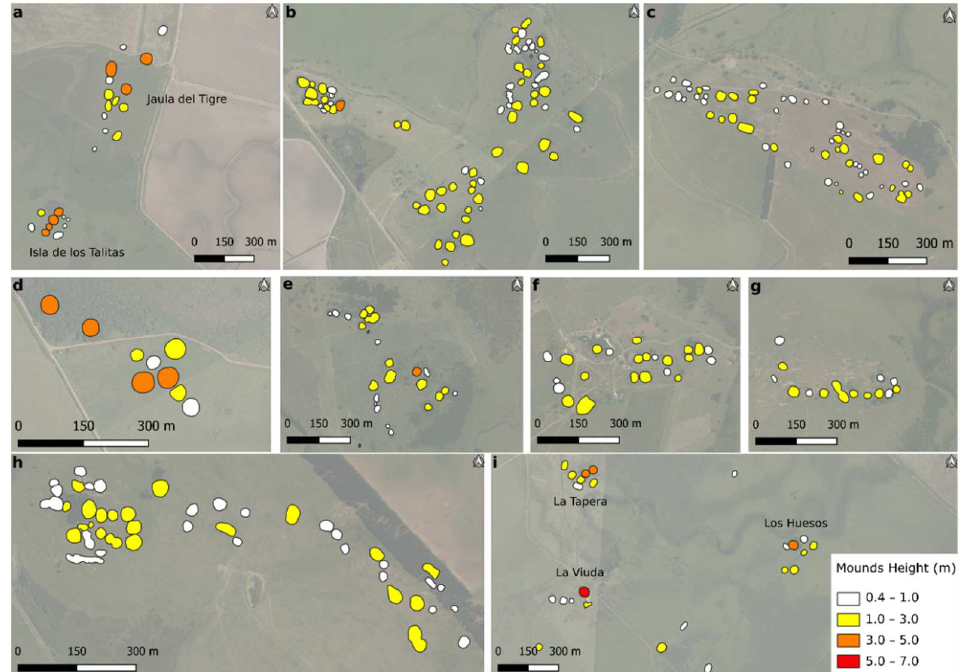
Figure 7. Comparative boxplots among the regional clusters. ( a ) Emplacement level of the mounds; ( b ) height distribution of the mounds.